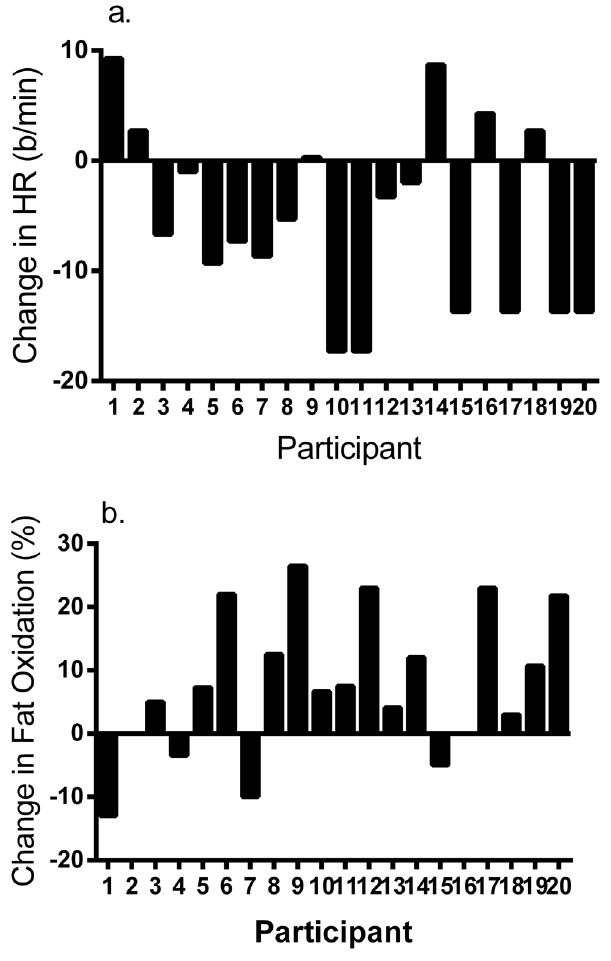
Figure 2. Individual responses for a) change in exercise HR and b) lipid oxidation in response to 2 wk of low-volume